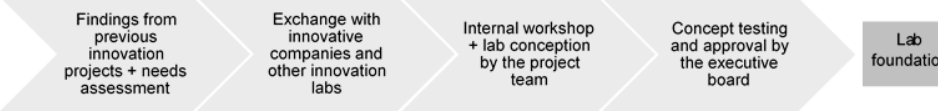
Figure 1. Process sequence for the foundation of journalism innovation